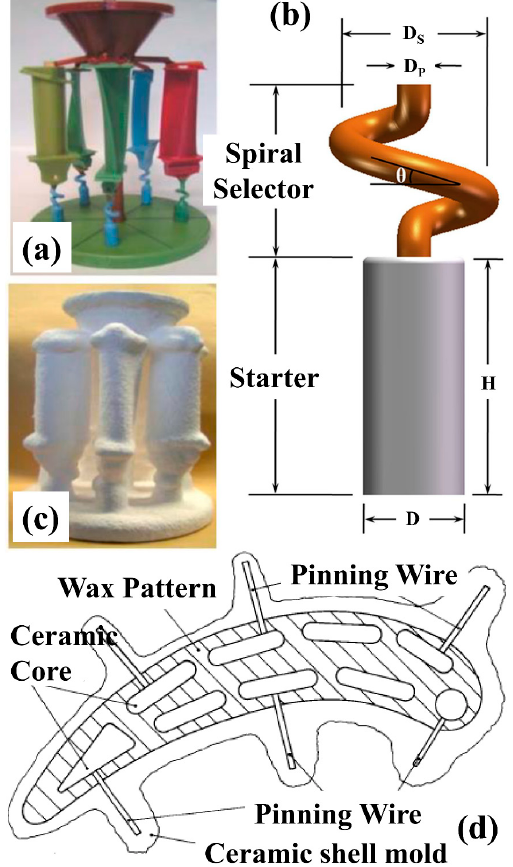
Figure 5. ( a ) Circular-clustered wax assembly (Reproduced from [21] under the terms of the Creative Commons Attribution 4.0 License from http: // creativecommons.org / licenses / by / 4.0 / ); ( b ) schematic of a pigtail demonstrating how the turns in the block selector function to cull unwanted crystal orientations until only one orientation remains (Reproduced with permission from [24]); ( c ) the shell mold corresponding to a wax assembly in ( a ) for casting SX blades (Reproduced from [21] under the terms of the Creative Commons Attribution 4.0 License from http: // creativecommons.org / licenses / by / 4.0 / ); and ( d ) Cross-section of a ready-to-use mold demonstrating the pin placement used to stabilize the ceramic cores and the ceramic mold (Reproduced from [26] under the terms of the Creative Commons Attribution 4.0 License from http: // creativecommons.org / licenses / by / 4.0 /